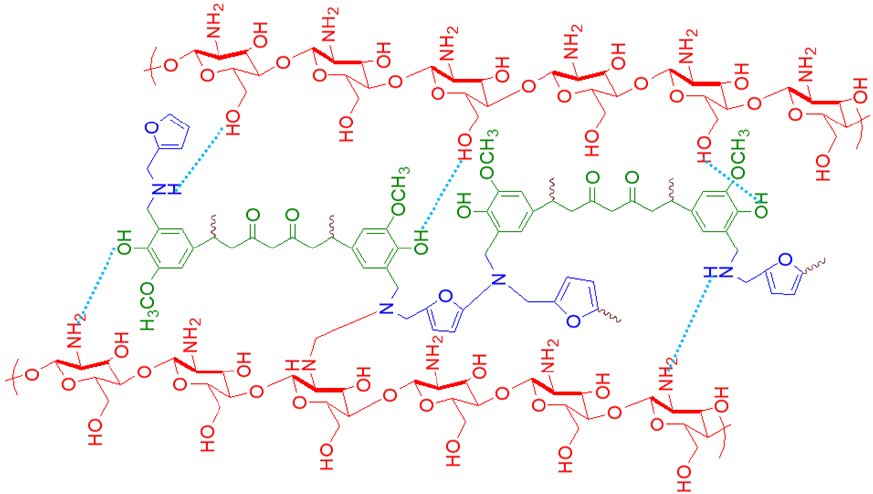
Scheme 4. Representative co-polymerization mechanism Ch and C-fu.